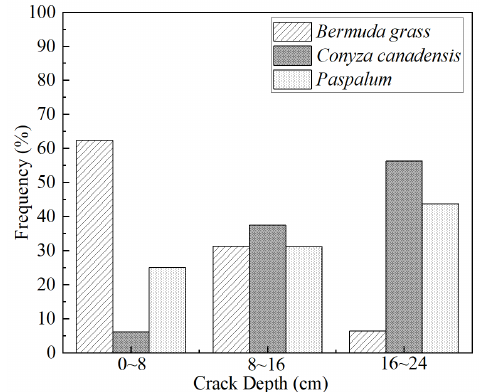
Figure 7. The frequency distribution of the CCC crack depths.